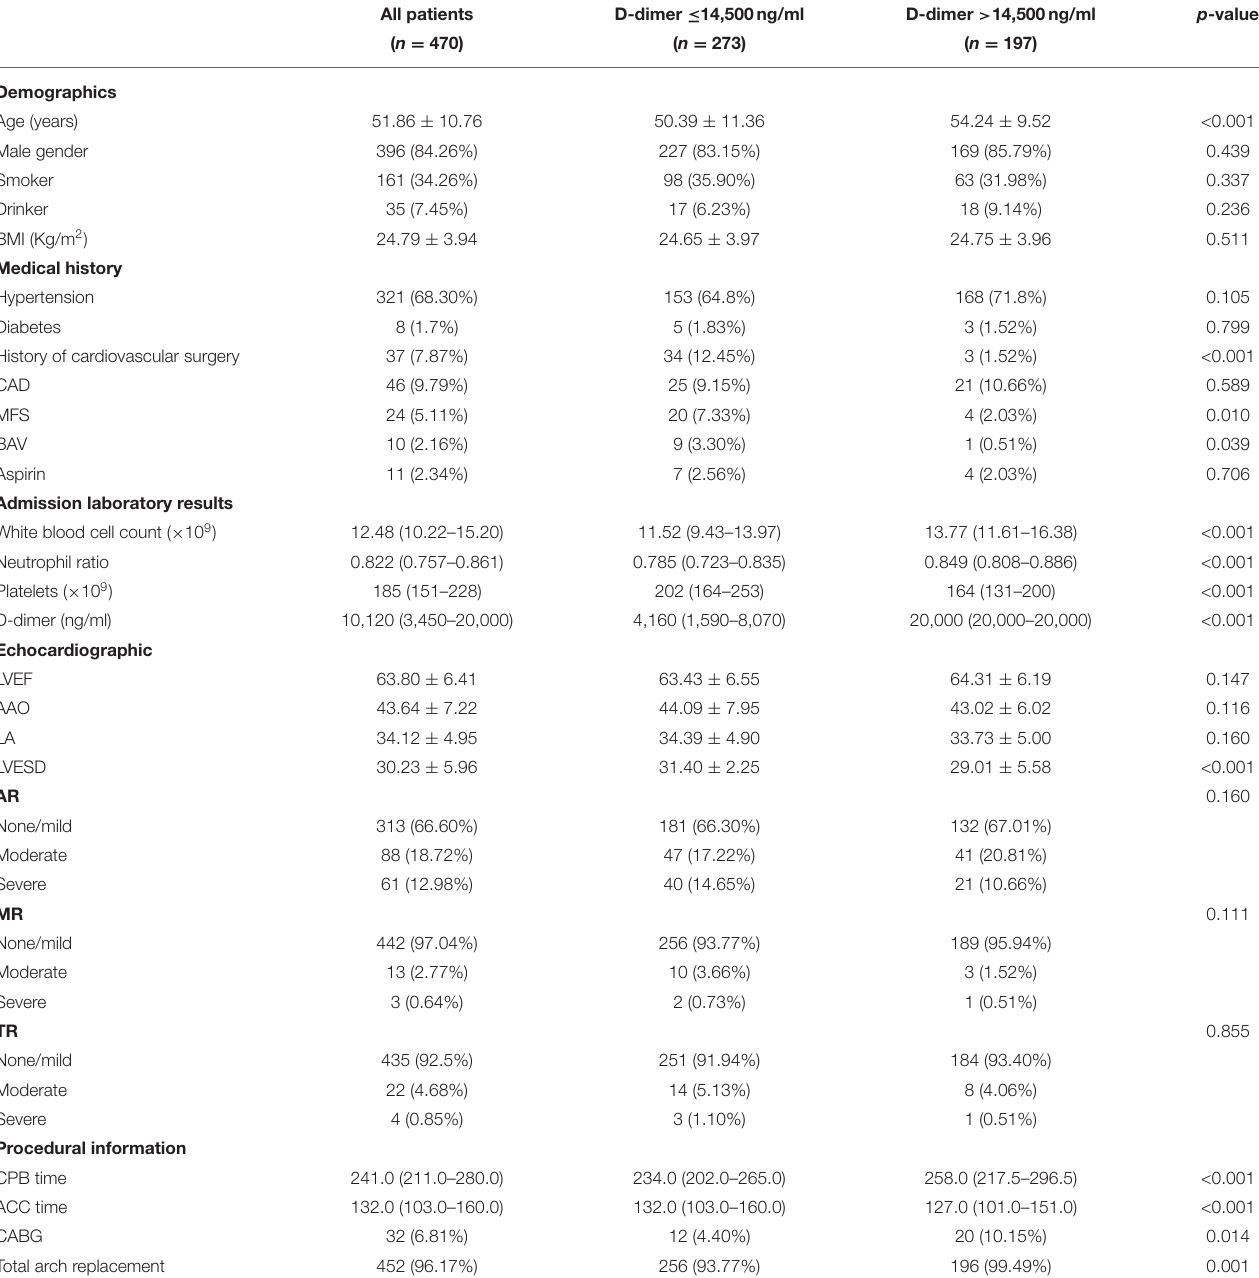
TABLE 1 | Patient